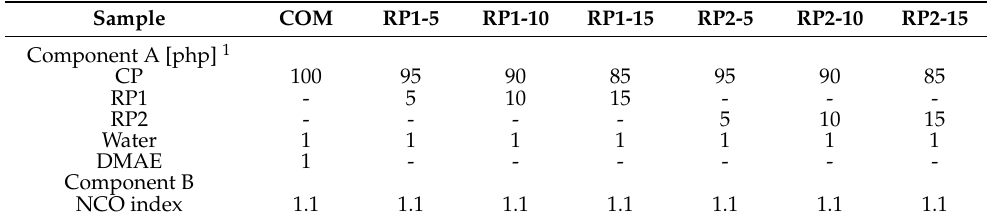
Table 2. Sample codes and formulations for